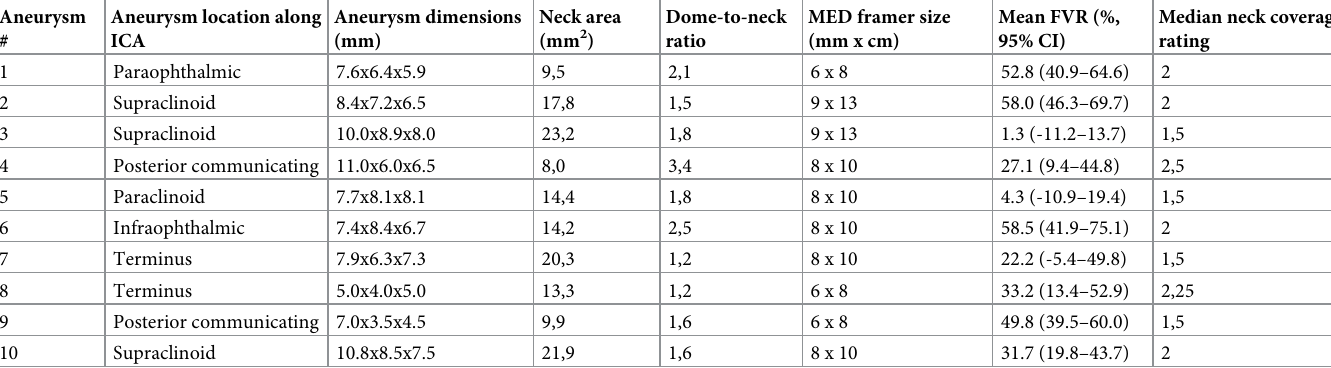
Table 1. Aneurysm